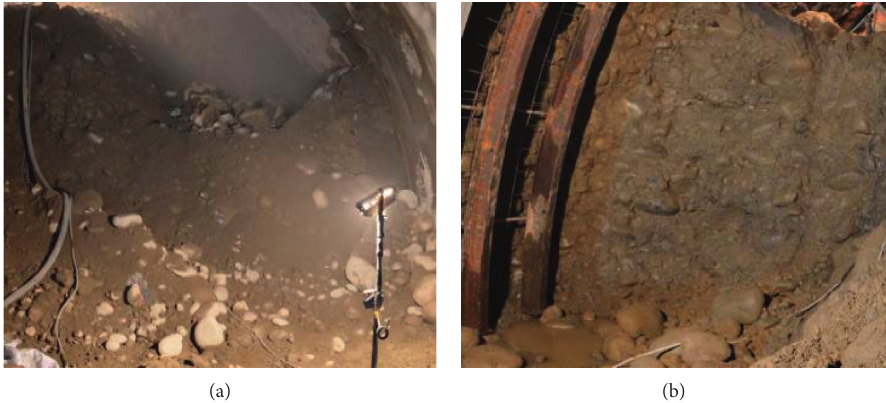
Figure 13: Comparisons of excavation surface conditions of two groups of sections. (a) Cross section 880. (b) Cross section 150.